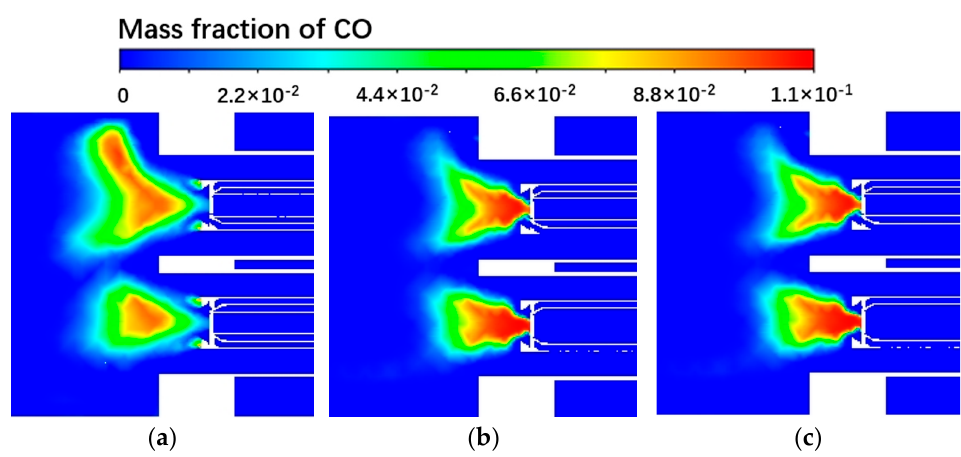
Figure 10. Calculation results of CO concentration distribution in each mode at startup stage. ( a ) Diffusion; ( b ) Sub-pilot premix; ( c ) Pilot premix.